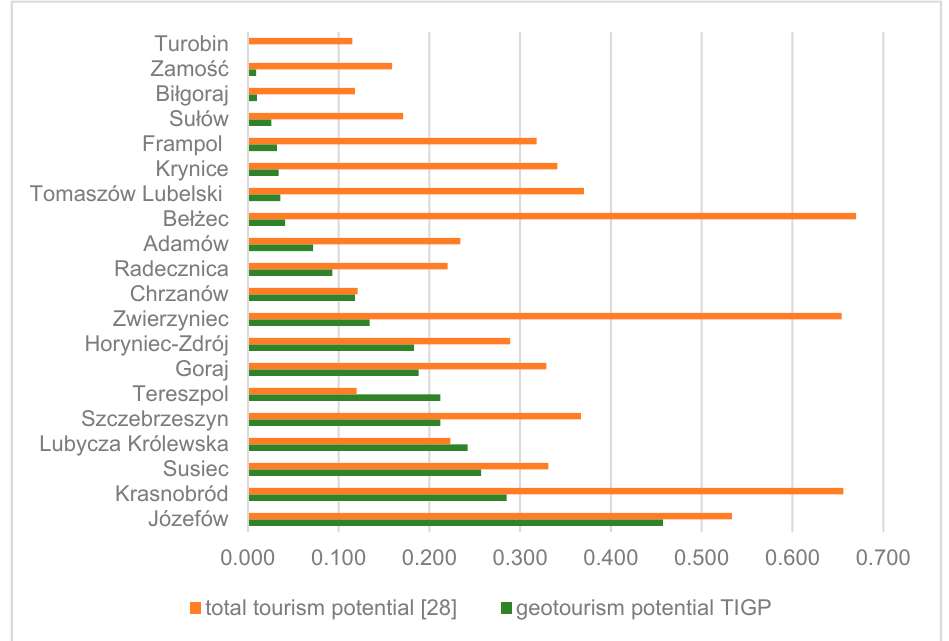
Figure 10. Comparison of the geotourism potential (TIGP) in the analyzed communes with the values of the total tourism potential [28].